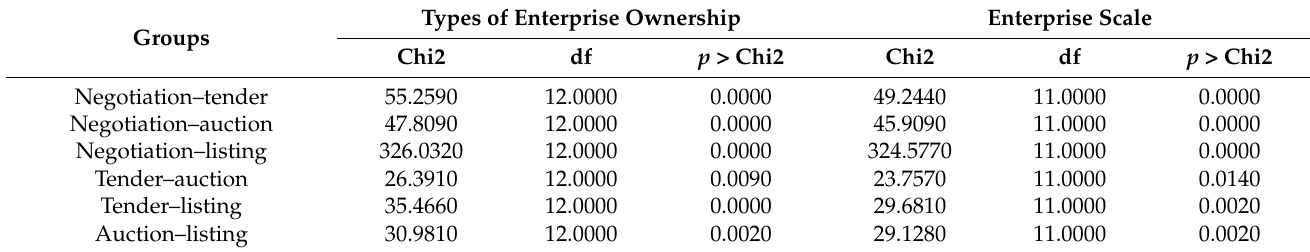
Table 11. Indifference test between groups, 2007.